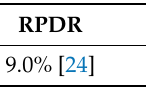
Table 6. Reference values of the operating parameters for RPES